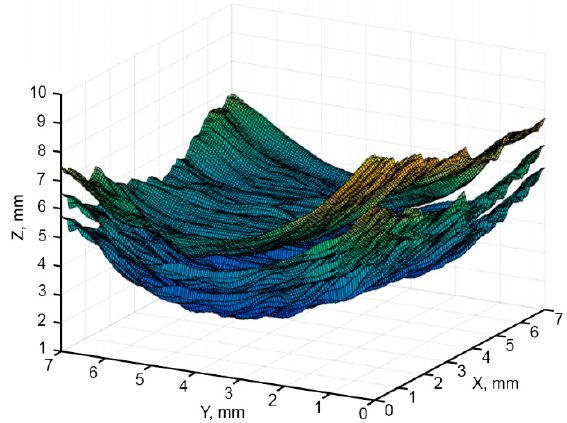
Figure 4. Fundus model reconstructed from OCT images.